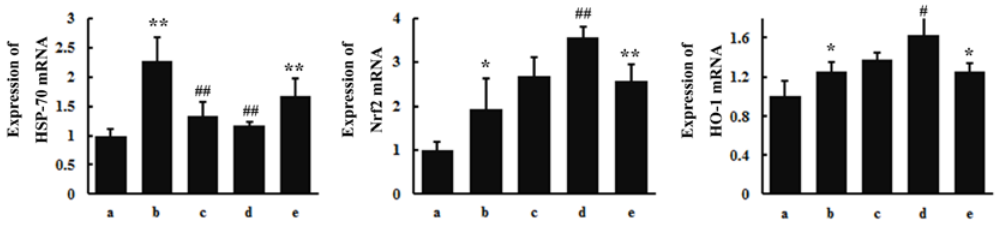
Figure 6. The gene expression levels of heat shock protein 70 (HSP-70), nuclear factor E2-related factor 2 (Nrf2), and heme oxygenase (HO-1) in rat brain. ( a ) control group; ( b ) SA group; ( c ) low dose TGP group; ( d ) high dose TGP group; ( e ) positive group. Values were expressed as mean ± SD. (* p < 0.05, ** p < 0.01 other groups vs. control group; # p < 0.05, ## p < 0.01 TGP group vs. SA group).